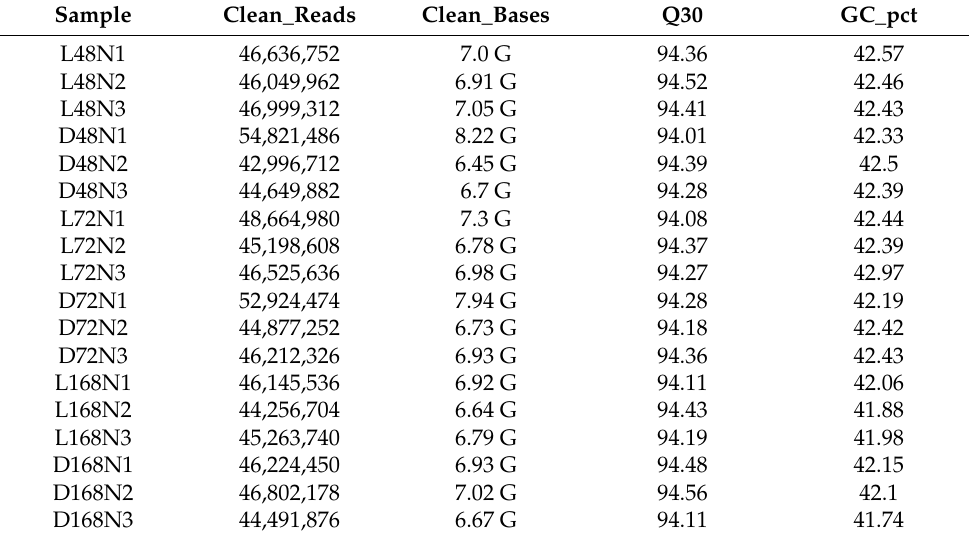
Table 1. Quality evaluation of sample sequencing output data for strand-specific RNA libraries.